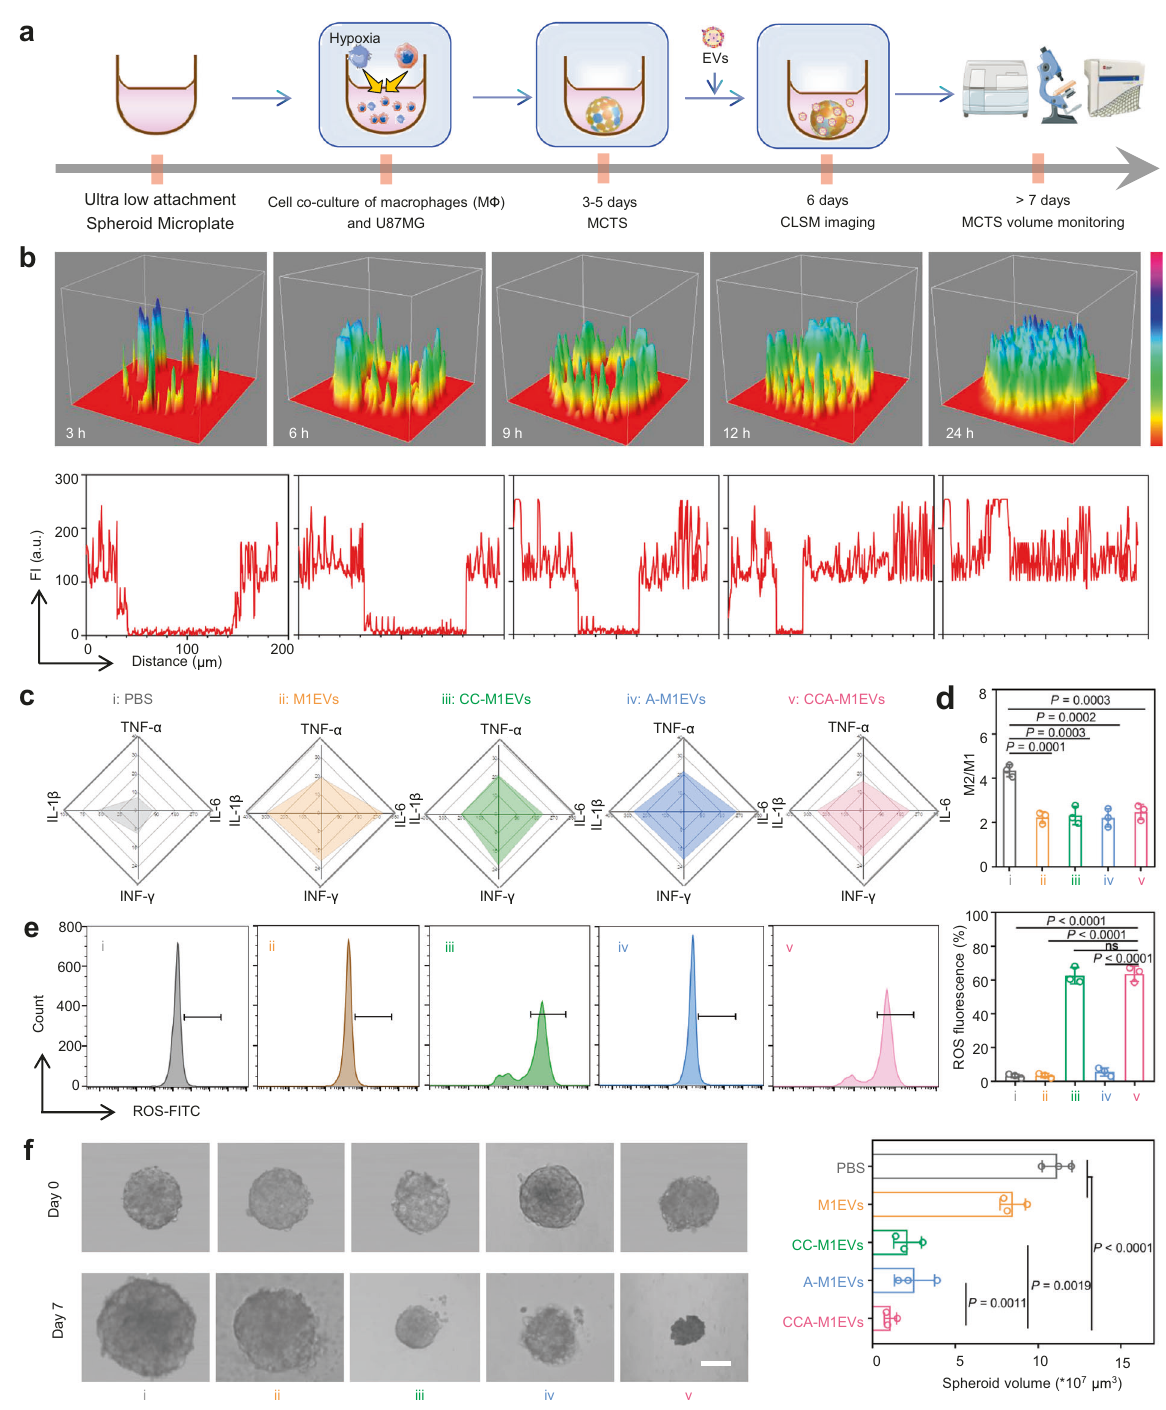
Fig. 4 In vitro evaluation of the antitumor effects of CCA-M1EVs on multicellular tumor spheroids (MCTSs). a . Illustration of in vitro three- dimensional tumor model. b . CLSM images of surface plots of DiD-labeled M1EVs penetration in MCTS (top); the corresponding fl uorescence signal intensity across the spheroids (bottom). c . The concentrations of IL-1 β , IL-6, TNF- α , and IFN- γ in supernatants prepared from the MCTS culture medium after treatments with PBS, M1EVs, CC-M1EVs, A-M1EVs, and CCA-M1EVs, respectively. d . Quantitative analysis of M2/M1 ratio of the MCTS based on fl ow cytometry analysis ( n = 3). e . Representative fl ow cytometry analysis images and corresponding quantitative analysis of the intracellular levels of ROS in U87MG cells treated with different EVs designs ( n = 3). f . Photographs of MCTSs at a certain time (day 0 and day 7) (left). The volume of MCTSs treated with different formulations at day 7 (right) ( n = 3). All images have the same scale of 100 μ m. For d , e , and f , data are presented as the mean ± S.D. Statistical signi fi cance between multiple groups was calculated using one-way ANOVA with a Kruskal-Wallis test ( d , e , and f ). ns, not signi fi cant